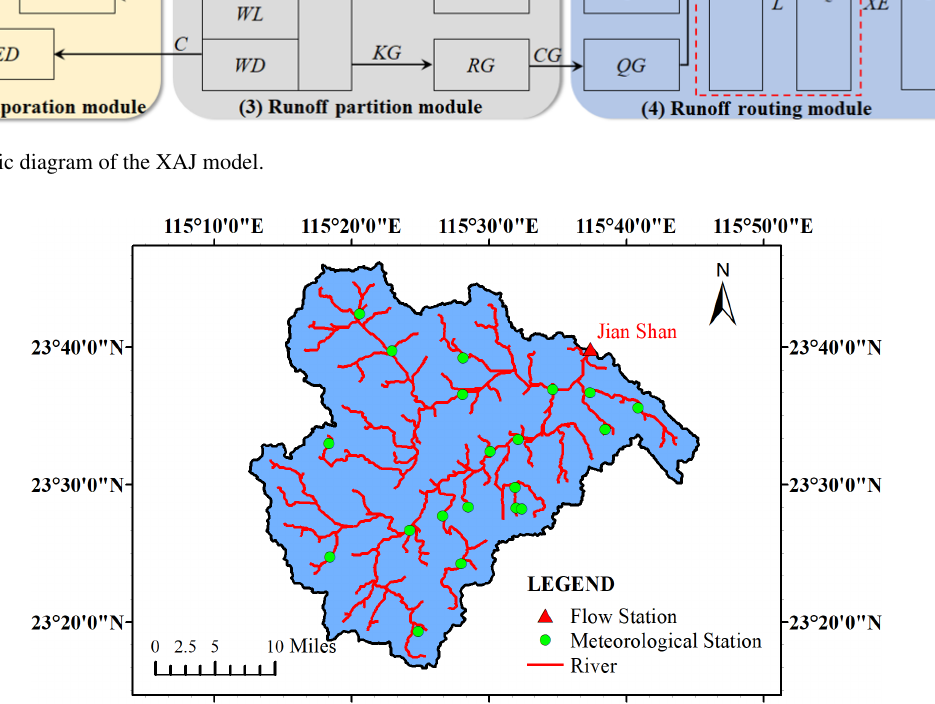
Figure 4. Locations of meteorological stations and gauging stations in the Qin River